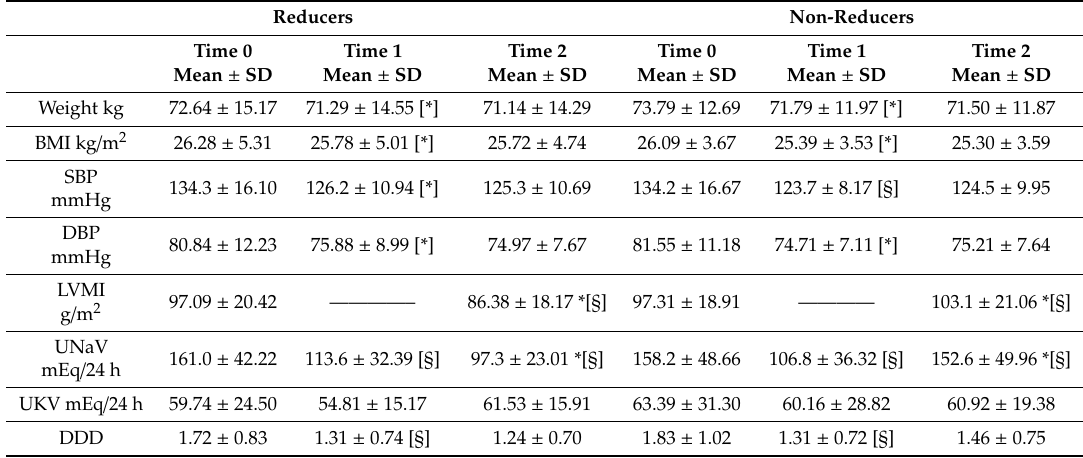
Table 2. Descriptive statistics of the two subgroups: Reducers and